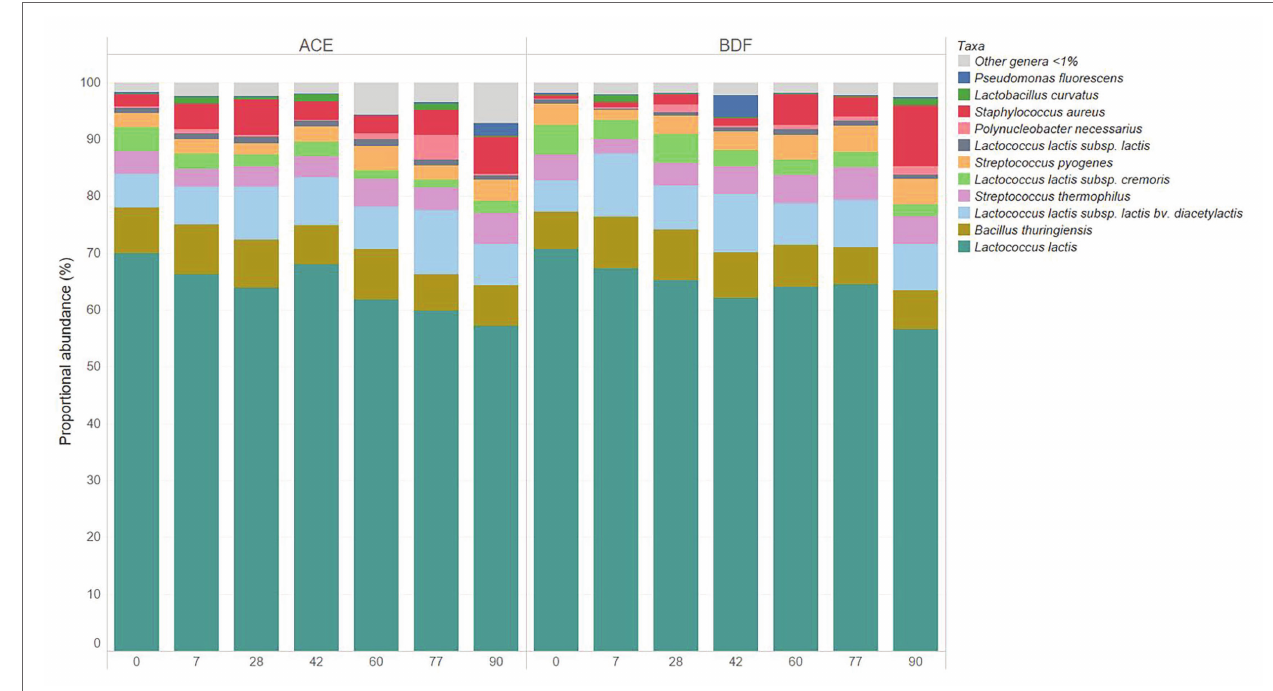
FIGURE 4 | Relative abundance of bacterial taxa during 10 ° C aging of Gouda cheese manufactured with unpasteurized milk (cheese ACE) or with unpasteurized milk inoculated with 1 log CFU/mL of Listeria monocytogenes (cheese BDF).